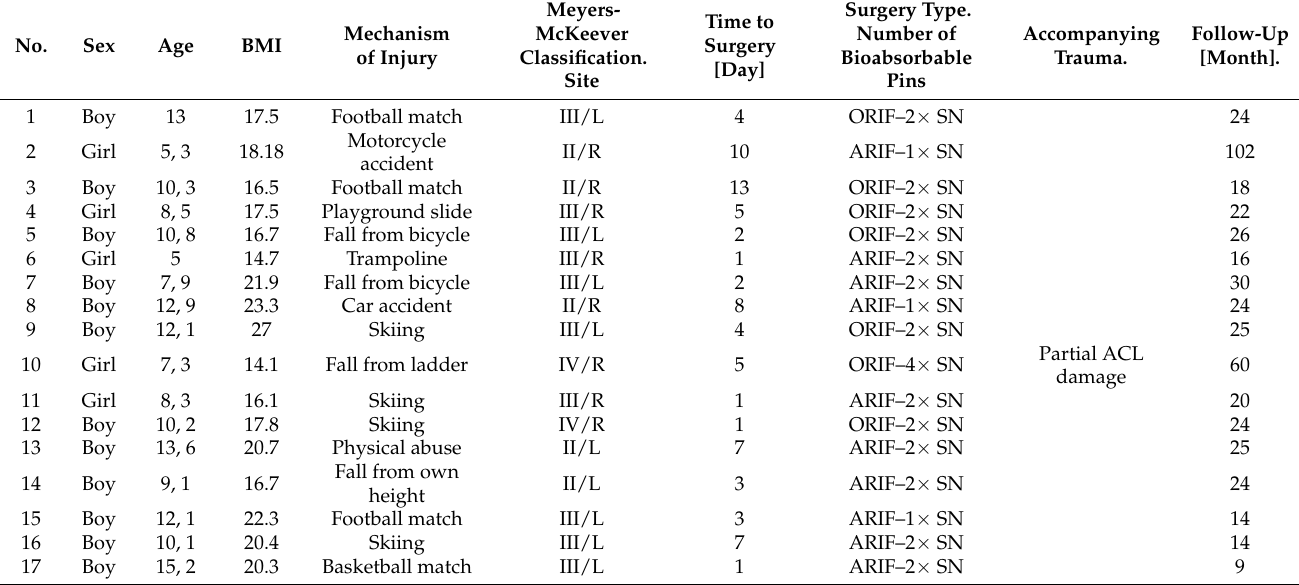
Table 1. Study group overview. BMI—Body Mass Index, L—left, R—right, ARIF—arthroscopic reduction and internal fixation, ORIF—open reduction and internal fixation,